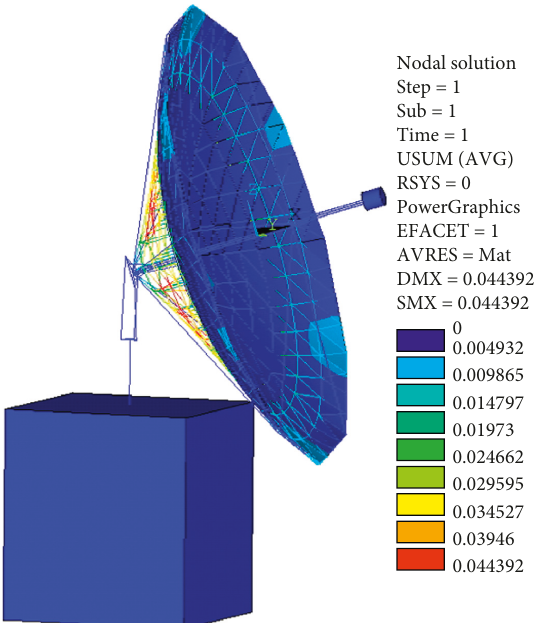
Figure 20: Deformation of the SSPCI at a limit orientation under the temperature load of 20 ° C.